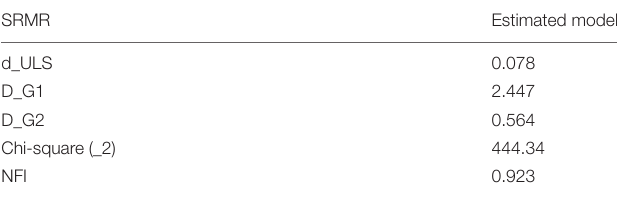
TABLE 6 | Model fit